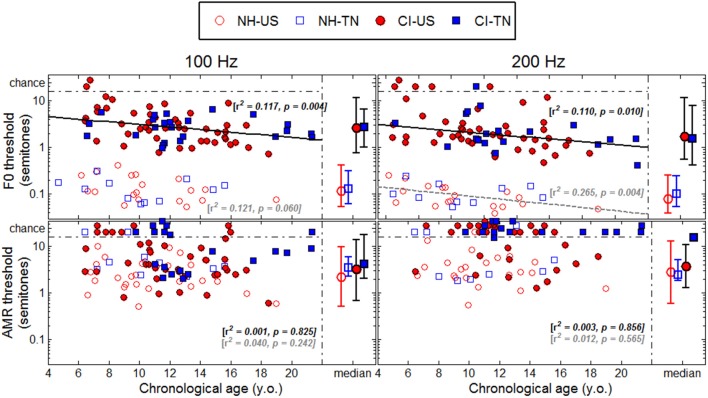
Thresholds (standardized at a d′-value of 0.77) as a function of chronological age. The medians are represented on the right side of each panel with the confidence intervals at 95% in each population.